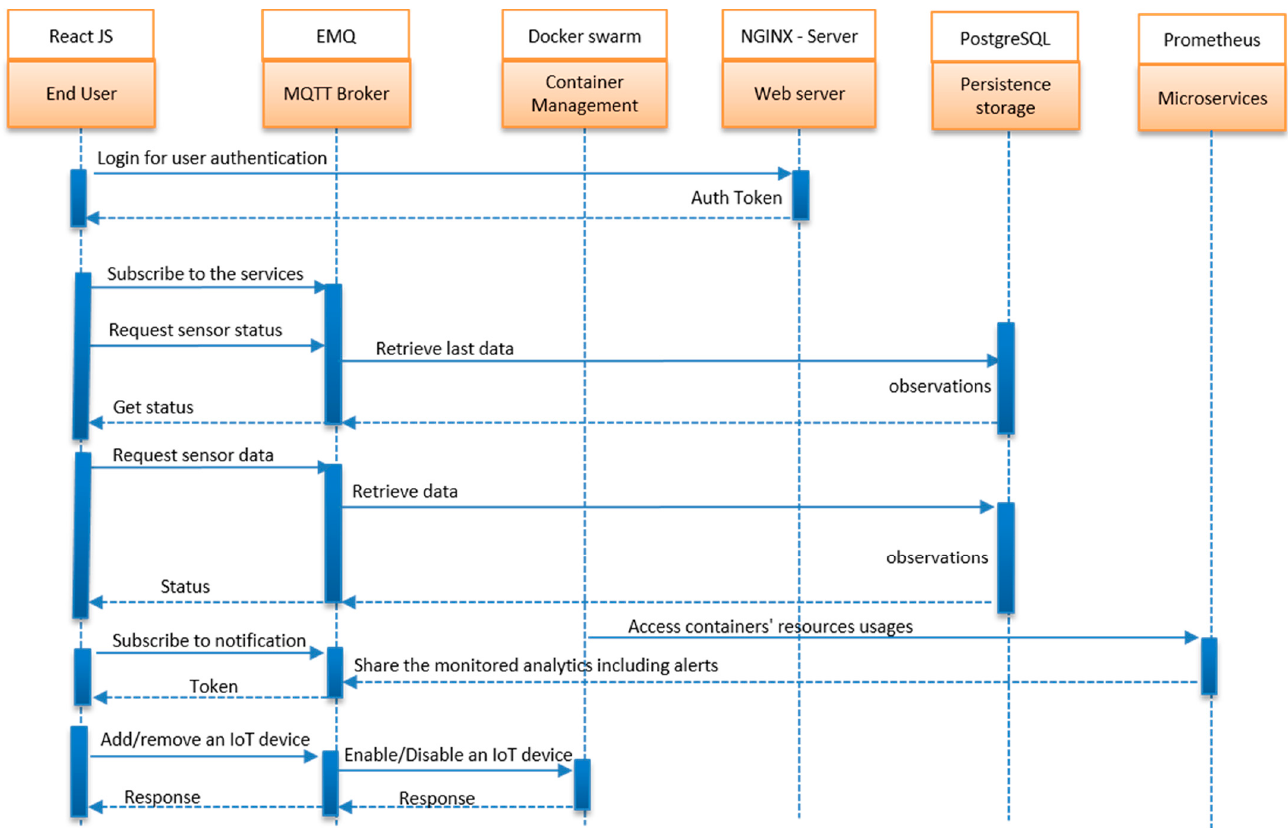
Figure 8. Sequence Diagram for End-User Perspective.